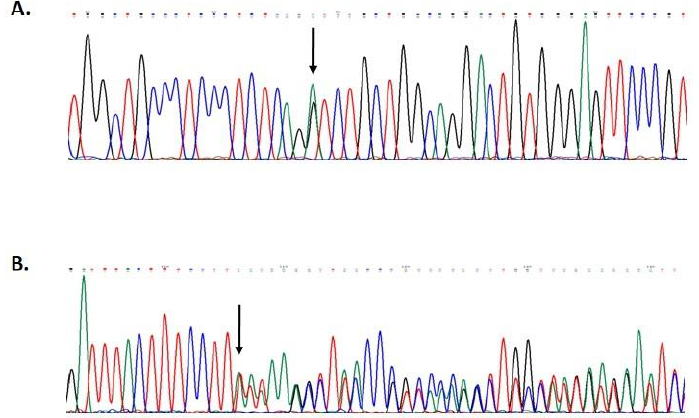
Figure 2. Partial electropherogram of MUTYH exon 13 ( A ); partial electropherogram of BRIP1 exon 1 ( B ).